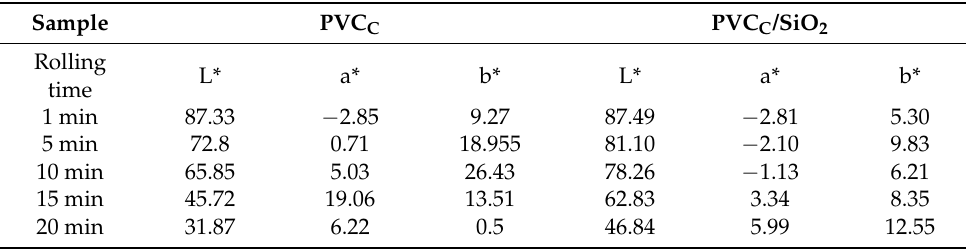
Table 2. Values of lightness L* and a*, b* coordinates for commercial PVC without SiO 2 (PVC C ) and with SiO 2 (PVC C /SiO 2